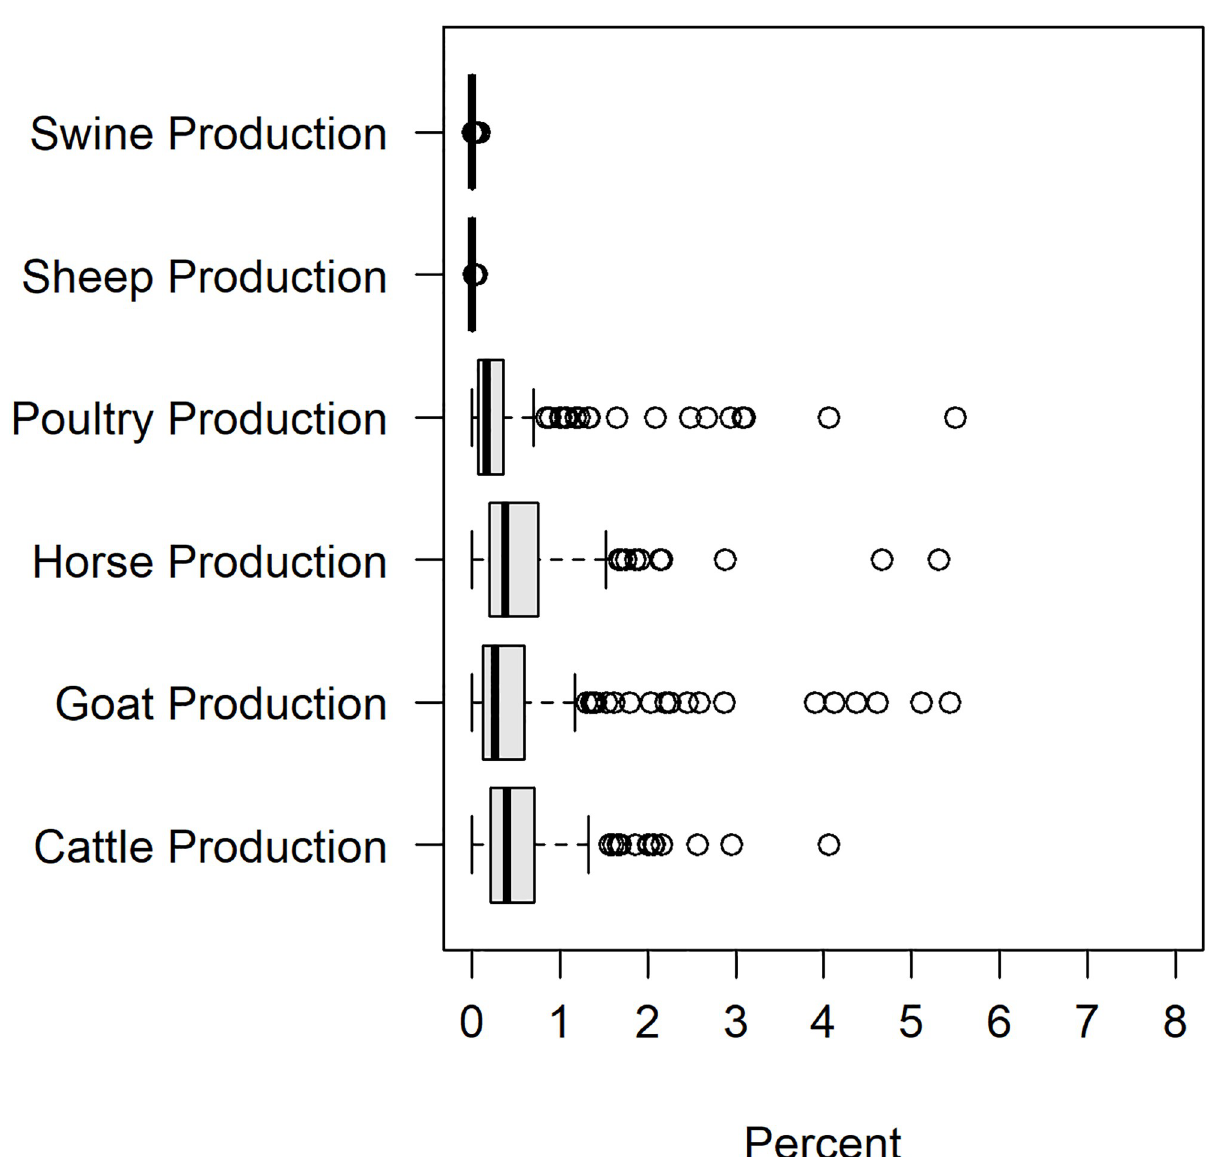
Fig 6. Distribution of percentages of each animal. Two municipalities not plotted in this figure, Mossoro and Parnamirim, had the largest poultry production of all municipalities. The percent of poultry production for both was approximately 16%.